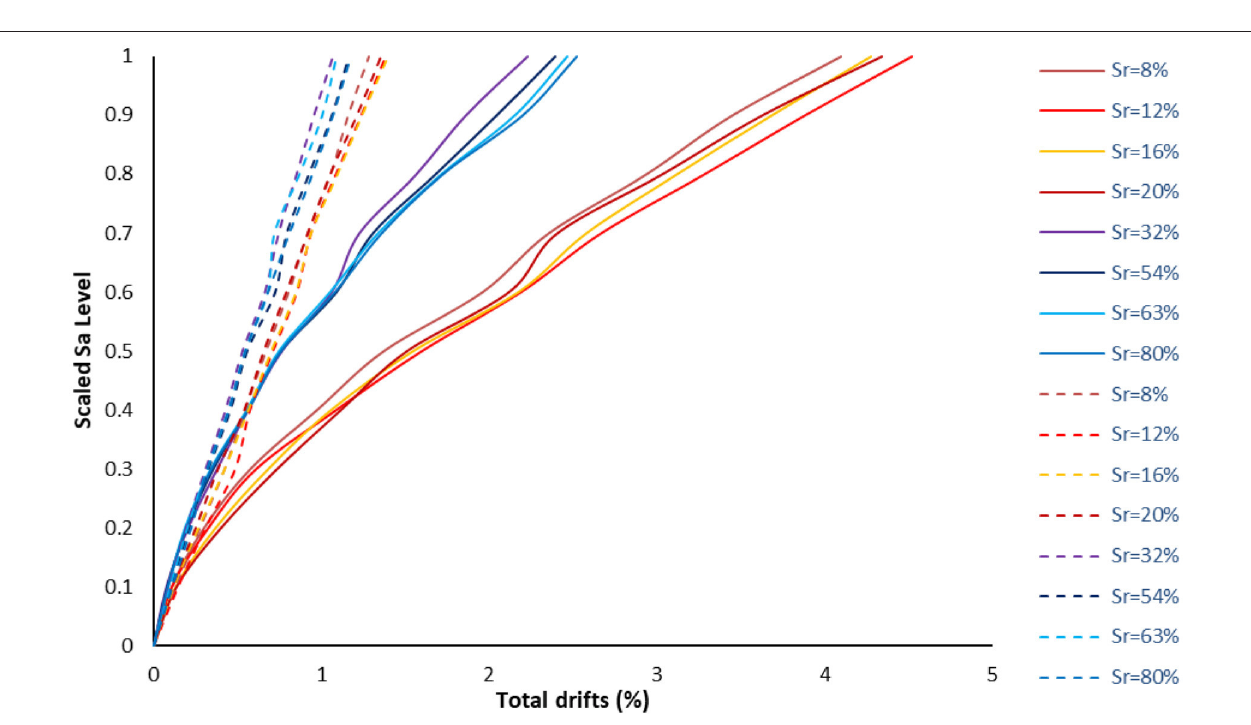
FIGURE 11 | Total drift median MSDA curves for the building in its initial state (solid curves) and the retrofitted building (dashed